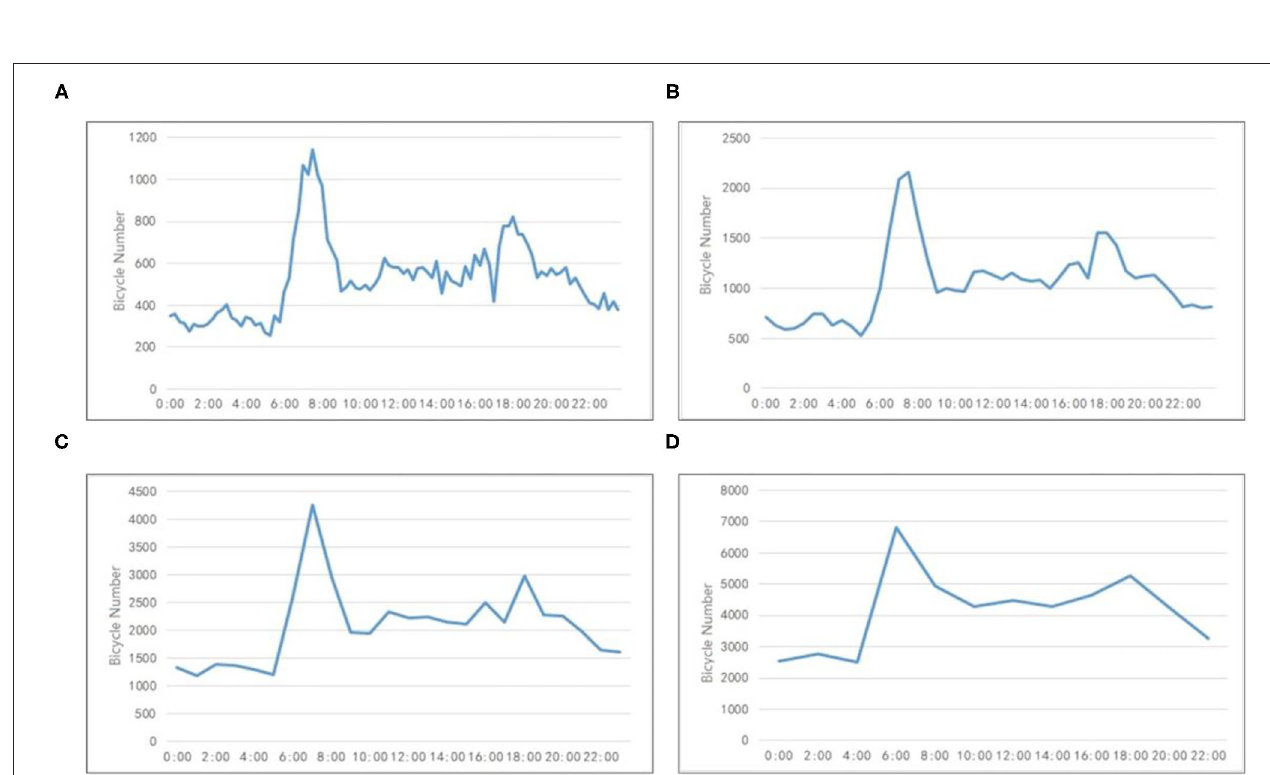
Frontiers in Public Health |